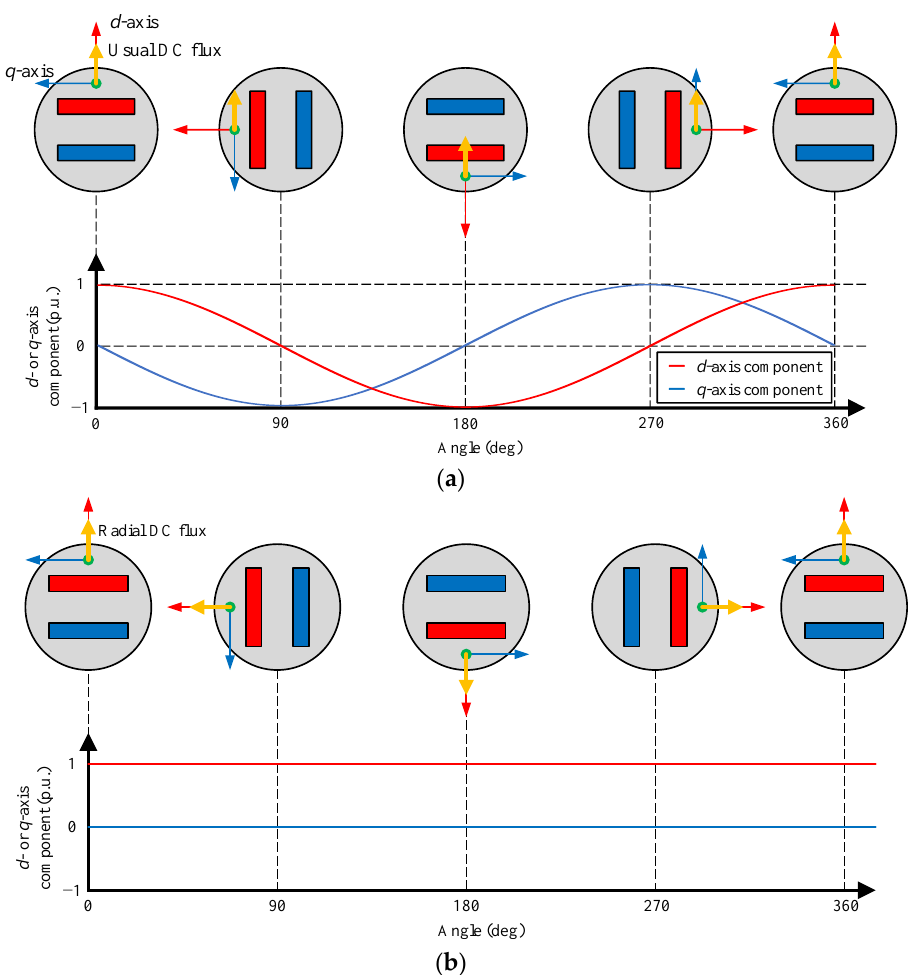
Figure 5. Variation in magnetic flux: ( a ) usual DC flux; ( b ) radial DC flux.